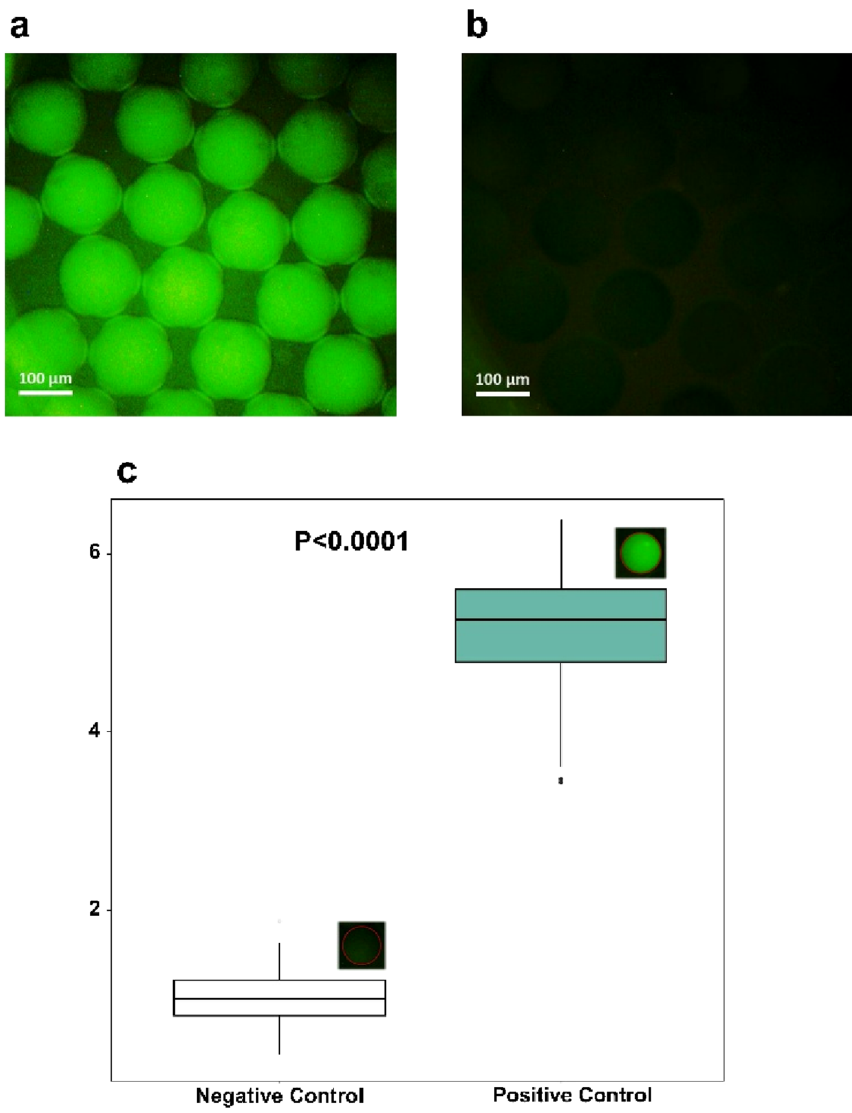
Figure 7. Representative fluorescence microscopy images of the droplets after 30 thermal cycles for ( a ) positive control reaction and ( b ) no template control (NTC) reaction. ( c ) Normalized fluorescence intensity of the positive (right) and negative (left) end-point signal. The results of the positive droplets were normalized to that of the NTC droplets. The average green pixel intensity of the positive droplets was significantly higher than that of the NTC ones. The bottom and top hinges of the boxplot show the first and third quartiles of a sample of 300 randomly selected droplets represented in each box, respectively. The medians are depicted by the horizontal lines in the middle, and the whiskers indicate min and max values. Outliers and the p-value are also shown. The p-value is calculated using two-tailed t-test for independent